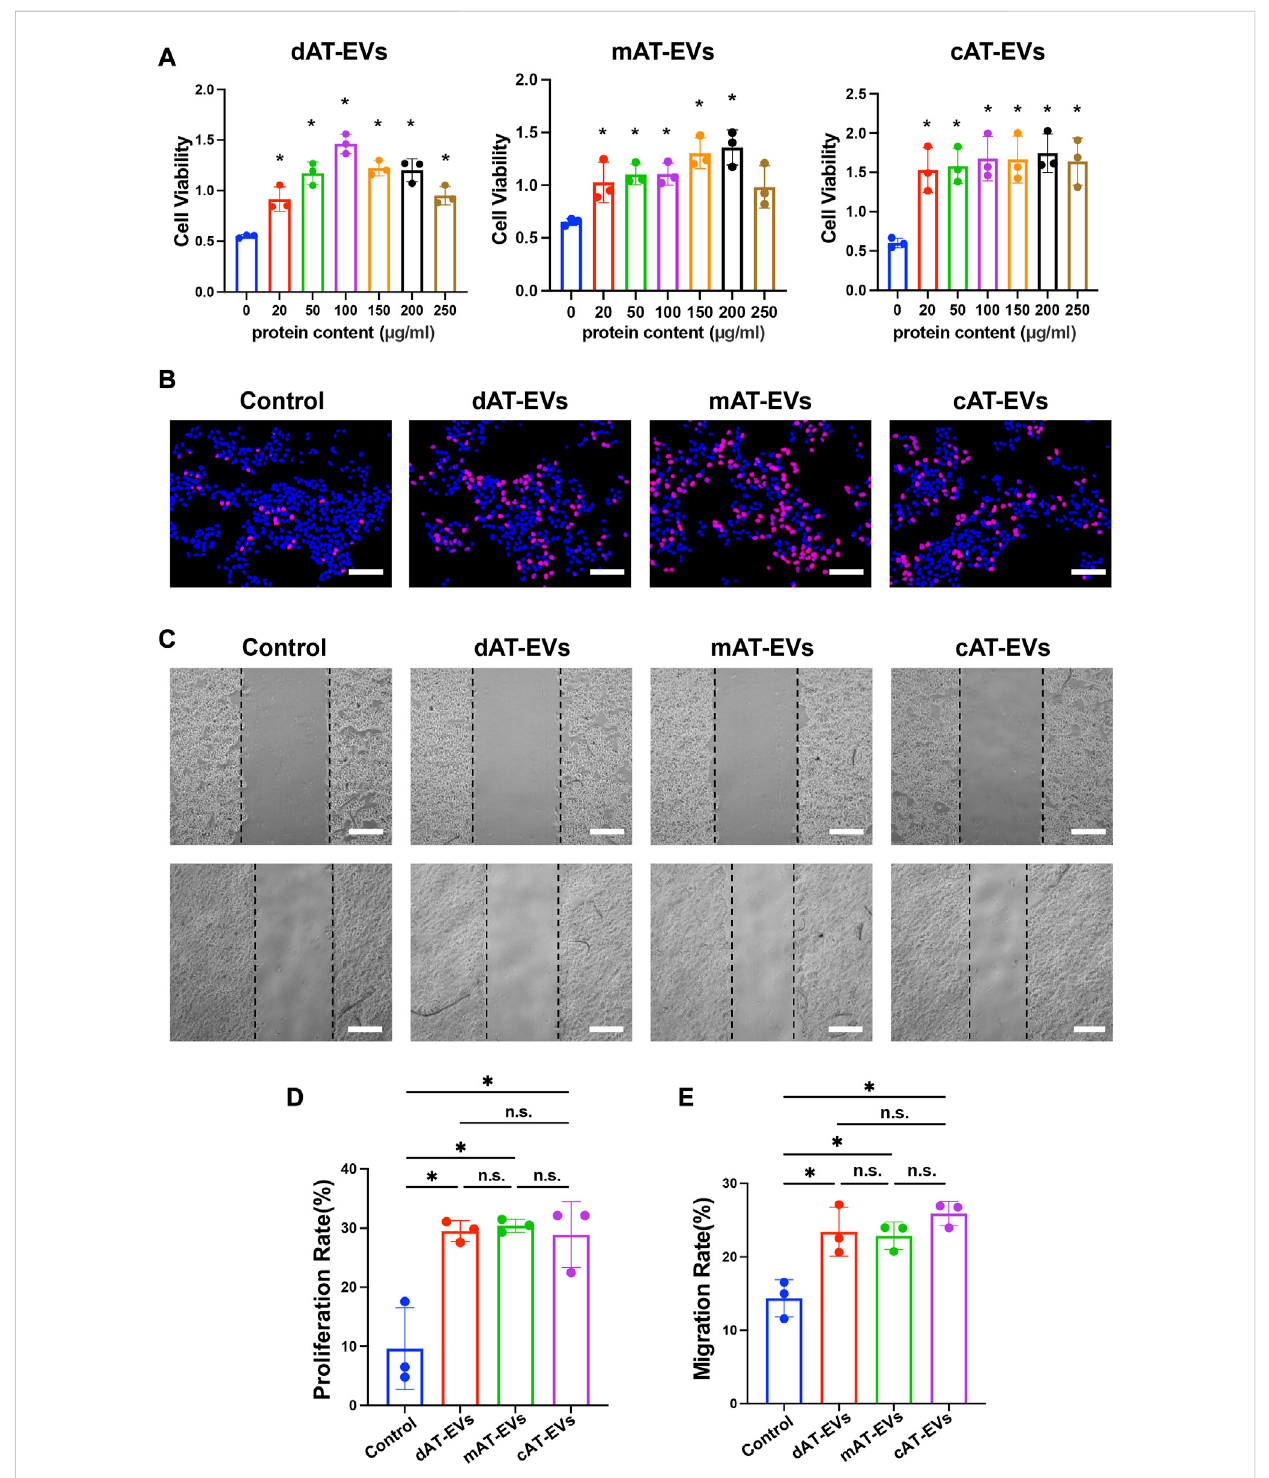
FIGURE 5 AT-EVs promoted cell activity, proliferation, and migration of HaCaTs in vitro (A) Cell viability of HaCaTs incubated with different concentrations of AT-EVsfor72 h( n =3). (B) CellproliferationdeterminedusingtheEdUassay;EdU-positiveHaCaTs(red)andnuclei(blue)wereobservedby fl uorescence microscopy; scalebar=100 μ m. (C) MigrationofHaCaTsafterincubationwith150 μ g/mLAT-EVs24 h( n =3).Scalebar=250 μ m. (D) Statisticalanalysis of HaCaTs ’ proliferation rate ( n = 3). (E) Statistical analysis of HaCaTs ’ migration rate ( n = 3). n. s. no signi fi cant difference observedbetween groups. * p <